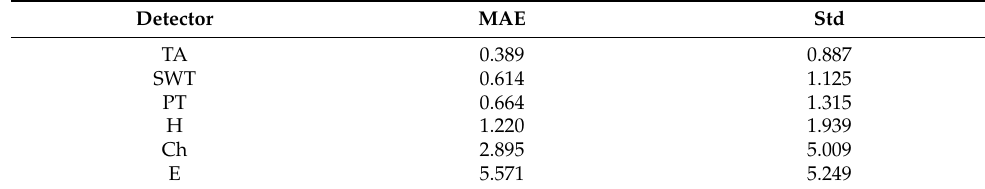
Table A1. R-peak determination Accuracy results using a one detector on a 1-lead signal. Detector